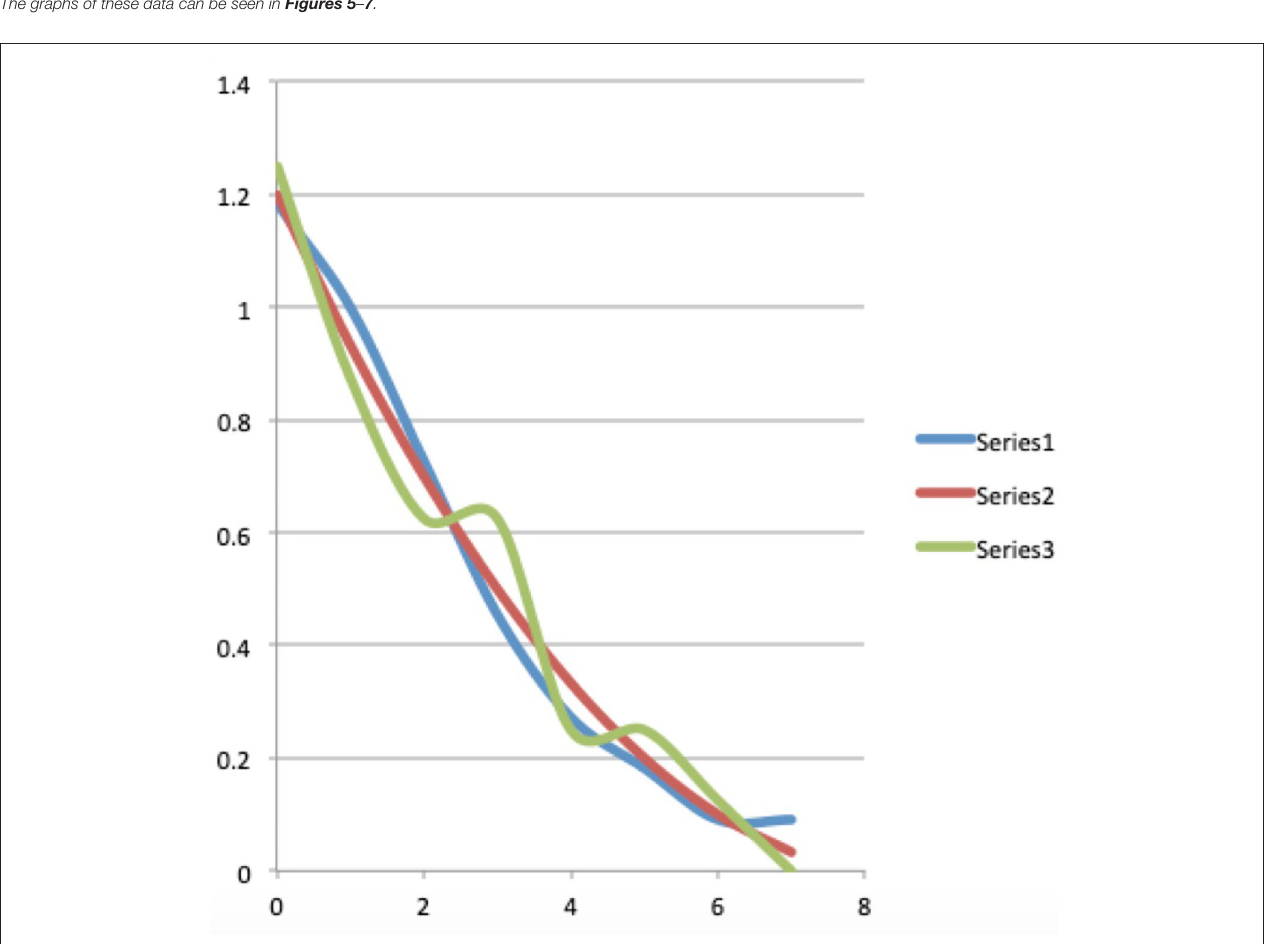
FIGURE 5 | The blue, red, and green curves are the graphs of the Bose-Einstein, Maxwell-Boltzmann, and Fermi-Dirac functions for the situation of four words distributed over seven energy levels with the total energy equal to seven.